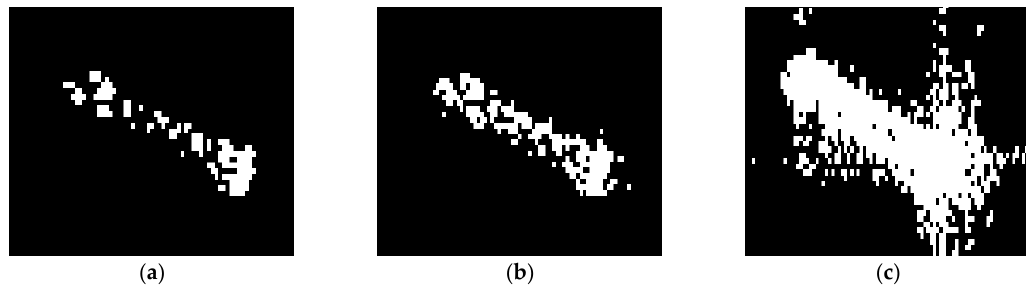
Figure 6. Detected results of a true target. ( a ) Detected result without TS; ( b ) Detected result without ICS; ( c ) Detected result with TS and ICS.